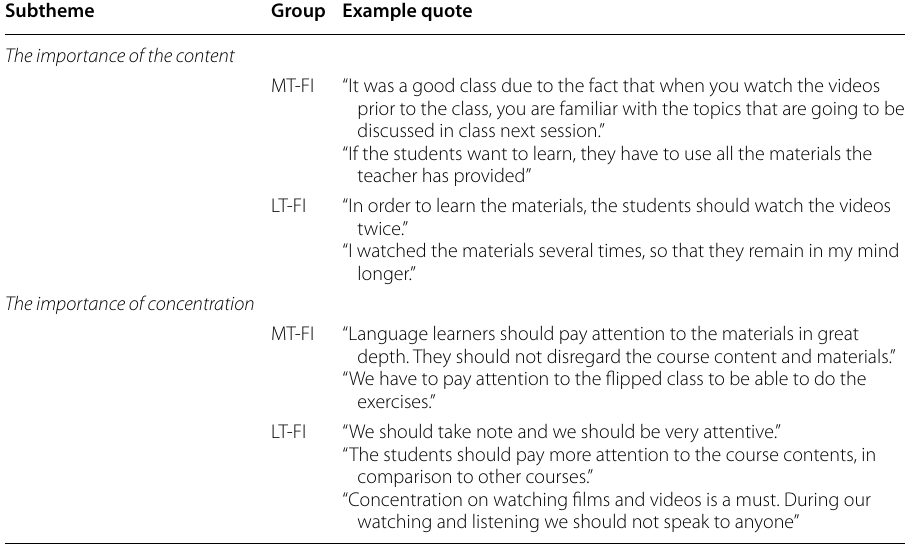
Table 11 Learning outcomes of